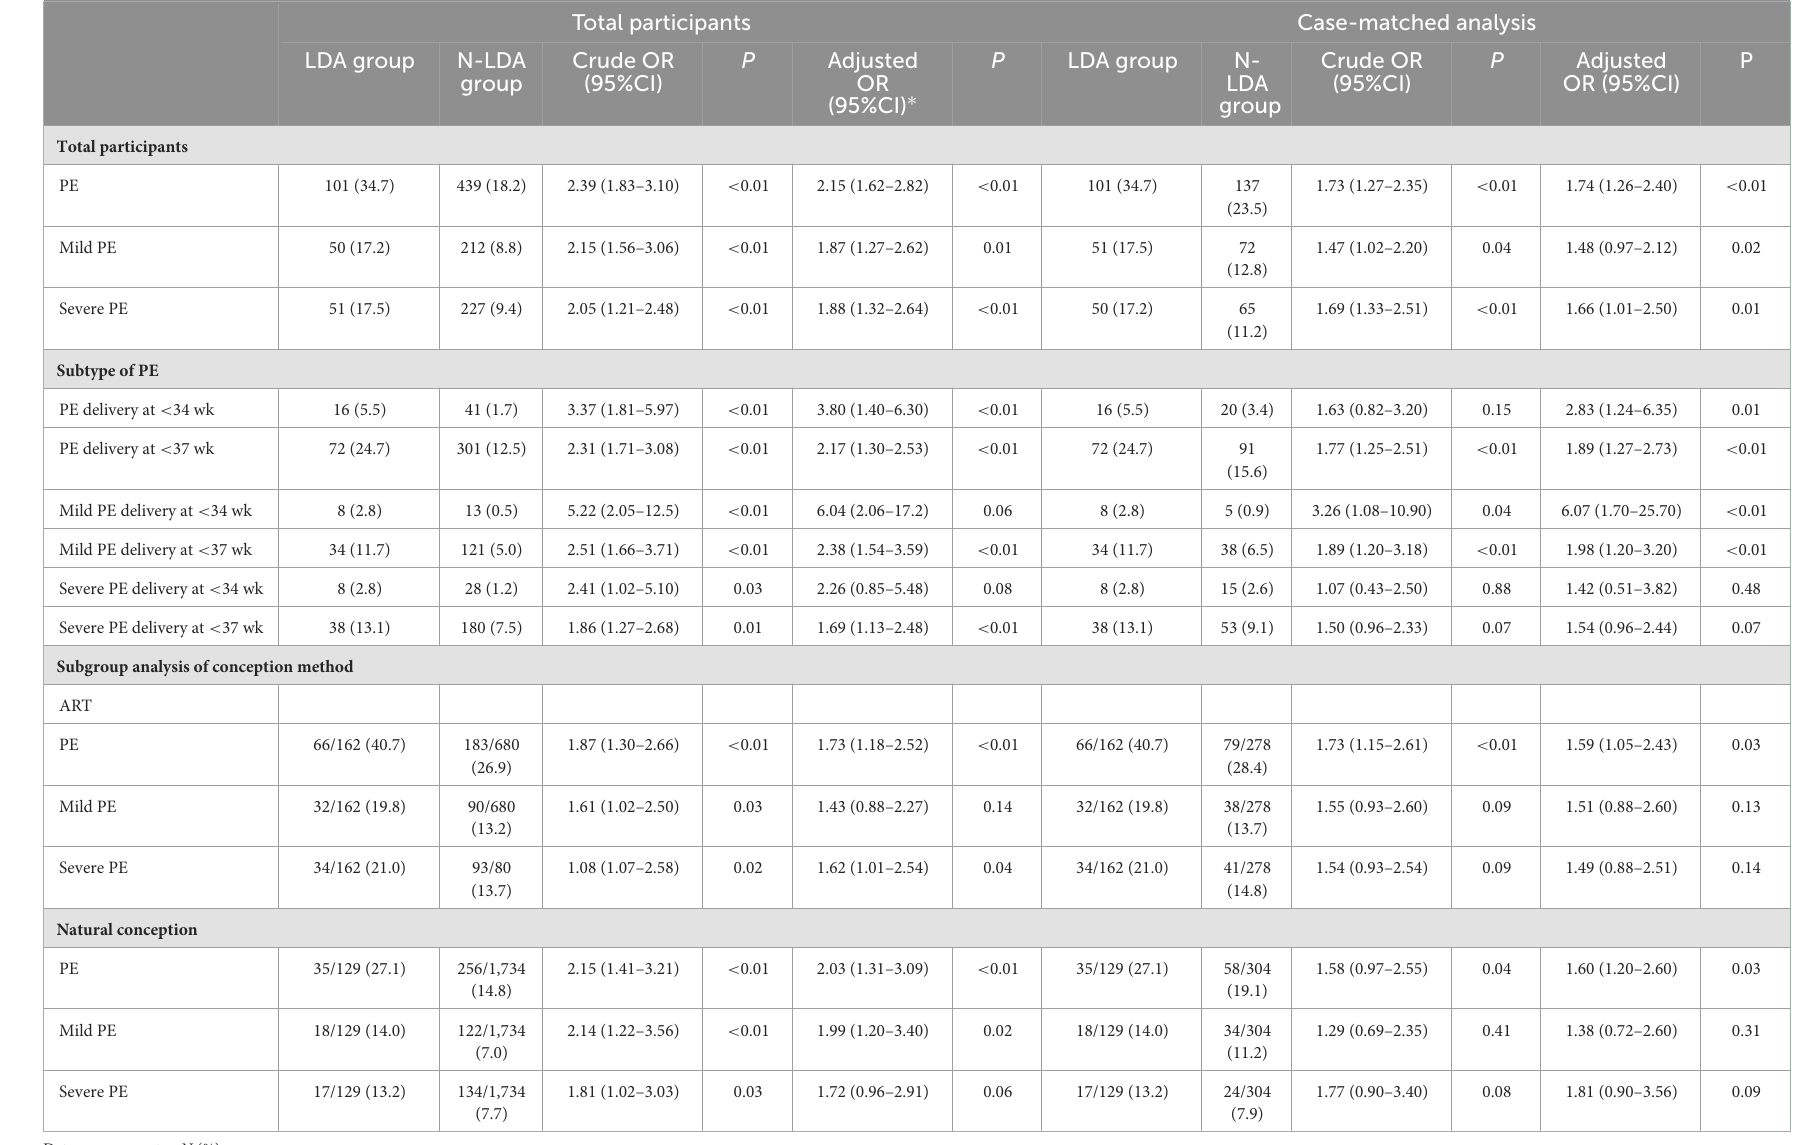
TABLE 2 Outcomes of total participants and case-matched